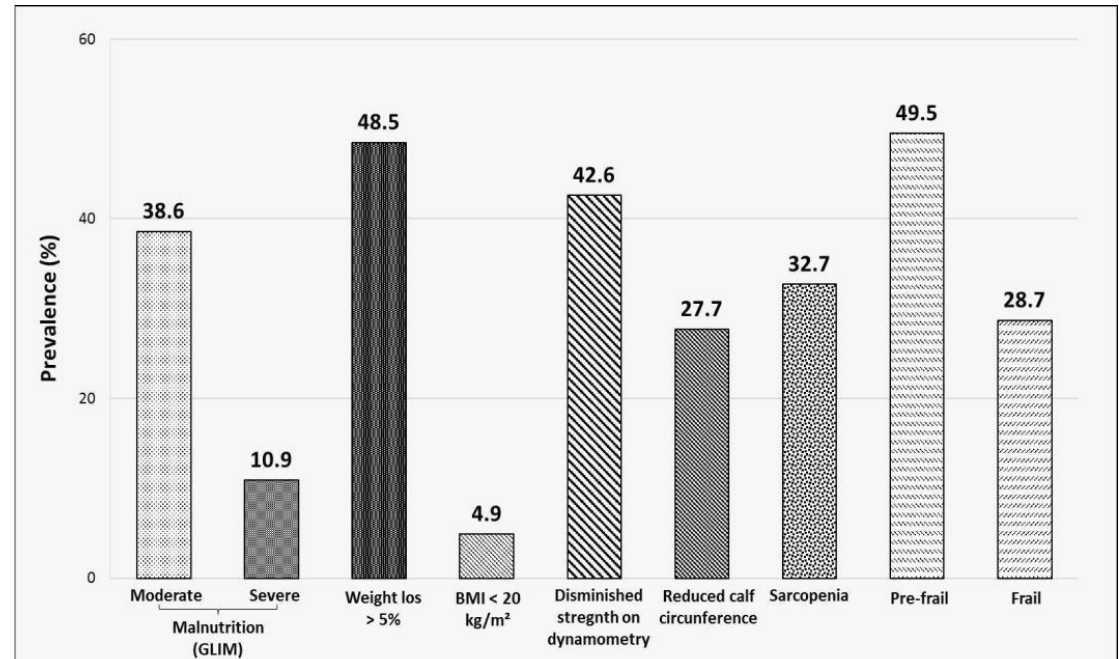
Figure 1. Prevalence of malnutrition and its components, sarcopenia, and frailty in the study sample. Prevalence expressed as percentage (%). Diagnosis of malnutrition was according to GLIM 2019 criteria (Global Leadership Initiative of Malnutrition). Sarcopenia was diagnosed according to the SARC-F screening tool. Frailty categorization by FRAIL scale (Fatigue, Resistance, Ambulation, Illnesses, Loss of Weight). BMI: body mass index. Table 2. Relationships between malnutrition, sarcopenia, and frailty.